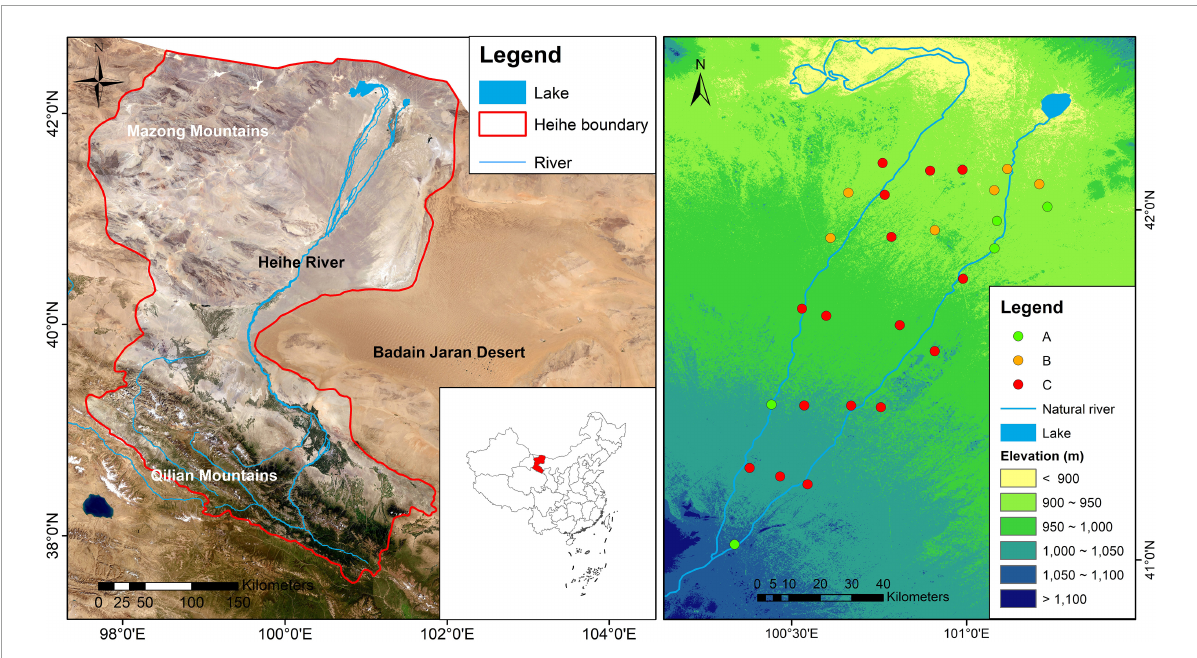
FIGURE1 Geographic locations of the Heihe river basin and its main topographic features and 27 sampling sites. The datasets originate from National Tibetan Plateau Data Center http://data.tpdc.ac.cn, and then the map was performed with ArcGIS 10. (A) Temperate broadleaf deciduous forest ( Populus euphratica Woodland); (B) Temperate broadleaf deciduous scrub ( Tamarix ramosissima scrub); (C) desert